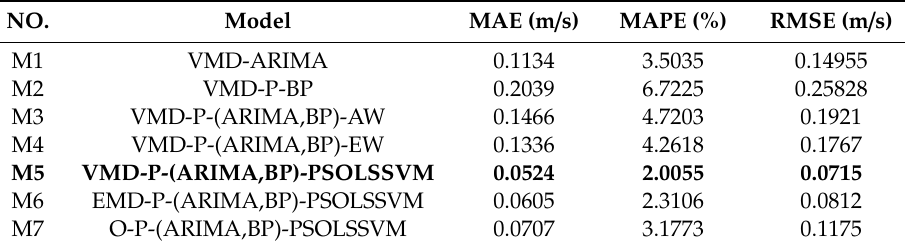
Table 10. Error indicators of all